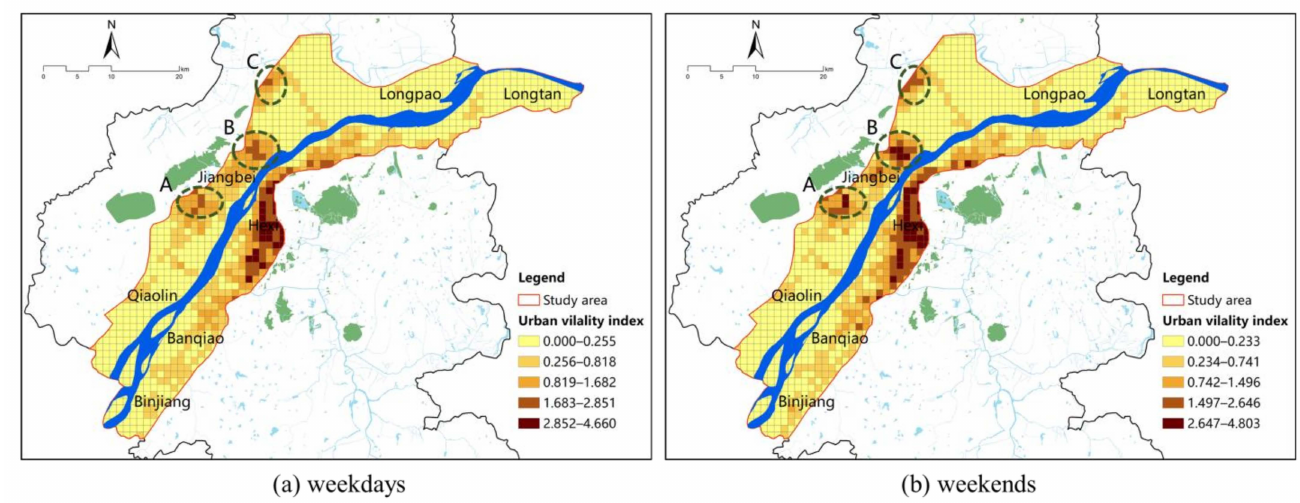
Figure 3. Spatial characteristics of urban vitality index in urban waterfronts: ( a ) urban vitality on weekdays; ( b ) urban vitality on